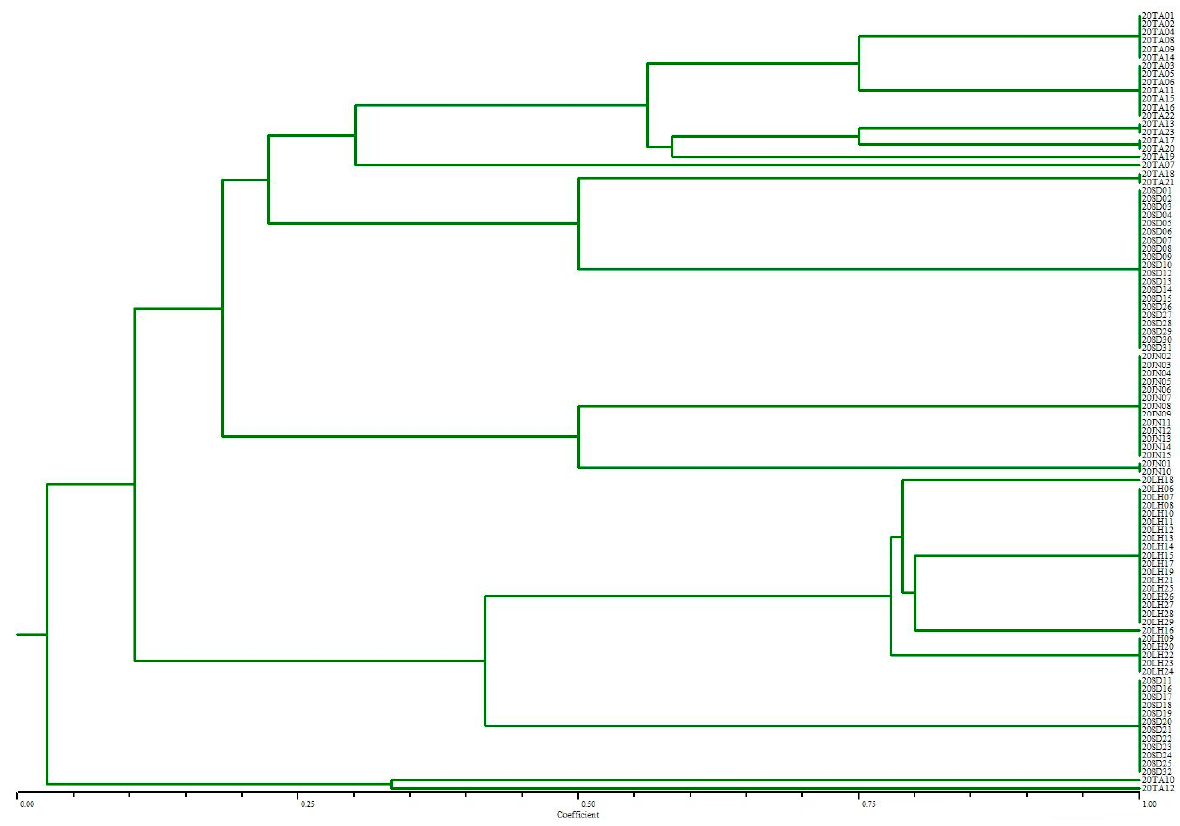
Figure 5. Genetic relatedness of 94 Salmonella isolates based on ERIC-PCR patterns. ERIC-PCR dendrogram exhibiting the genetic relatedness of Salmonella enterica isolated from four different breeds of breeder chickens. The clustering was performed using UPGMA.